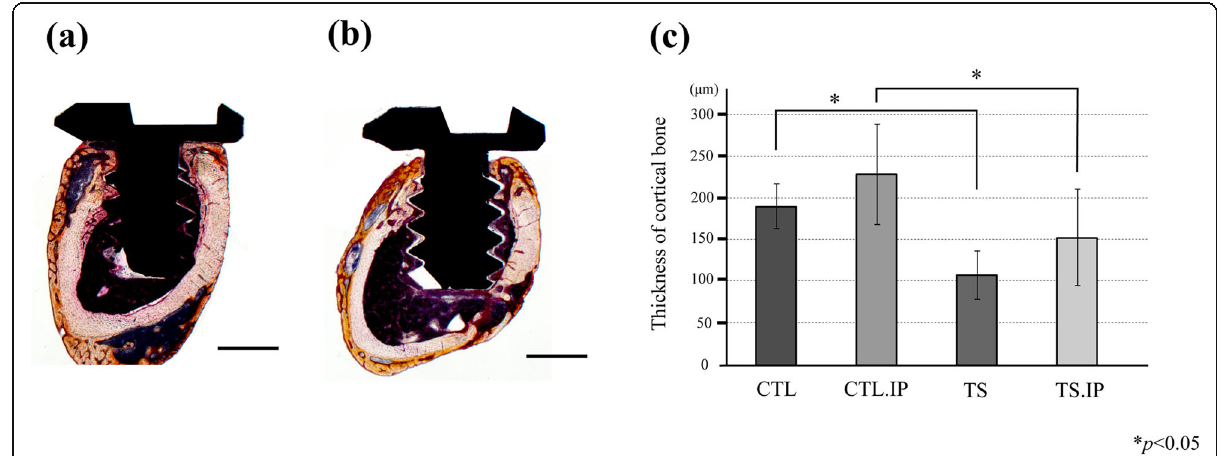
Fig. 6 Comparison of cortical bone thickness in each group. Villanueva bone stained image. a CTL.IP. 25× magnification. b TS.IP. 25× magnification. c Horizontal axis shows groups, vertical axis shows cortical bone thickness ( μ m). The thickness of cortical bone was significantly higher in the CTL and CTL.IP than in the TS and TS.IP. Bar: 500 μ